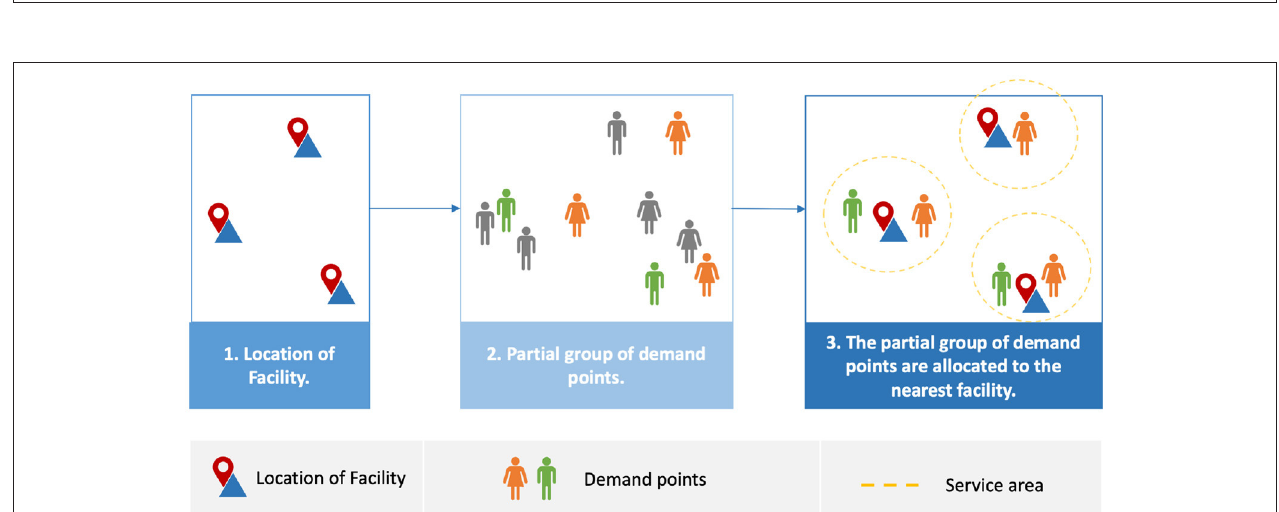
FIGURE 5 | Partial demand points